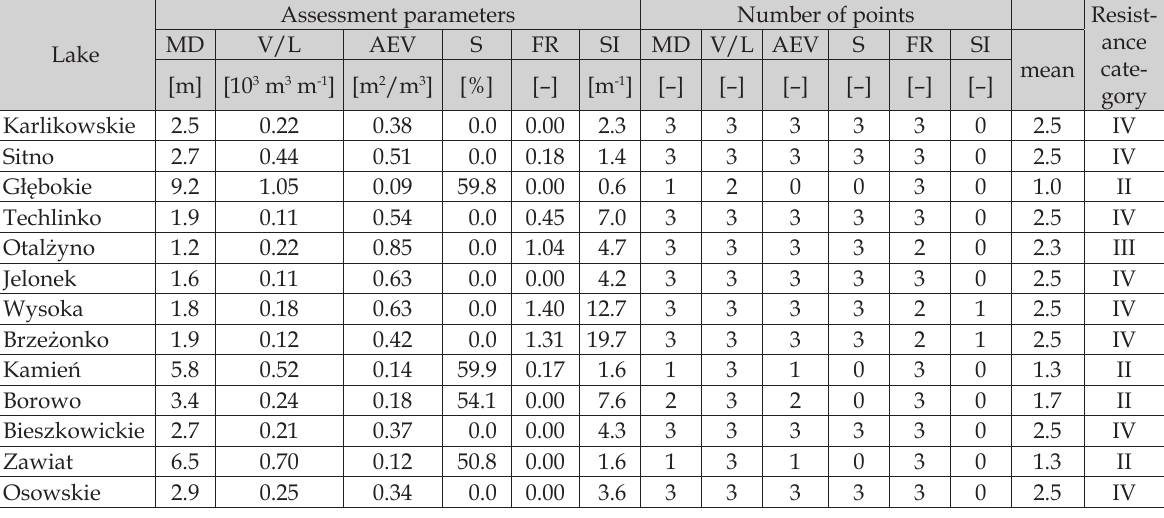
Table 4. Point assessment of resistance of lobelia lakes of Tricity area to supply of matter from catchment (based on field measurements) Assessment parameters Lake Karlikowskie Sitno Głębokie